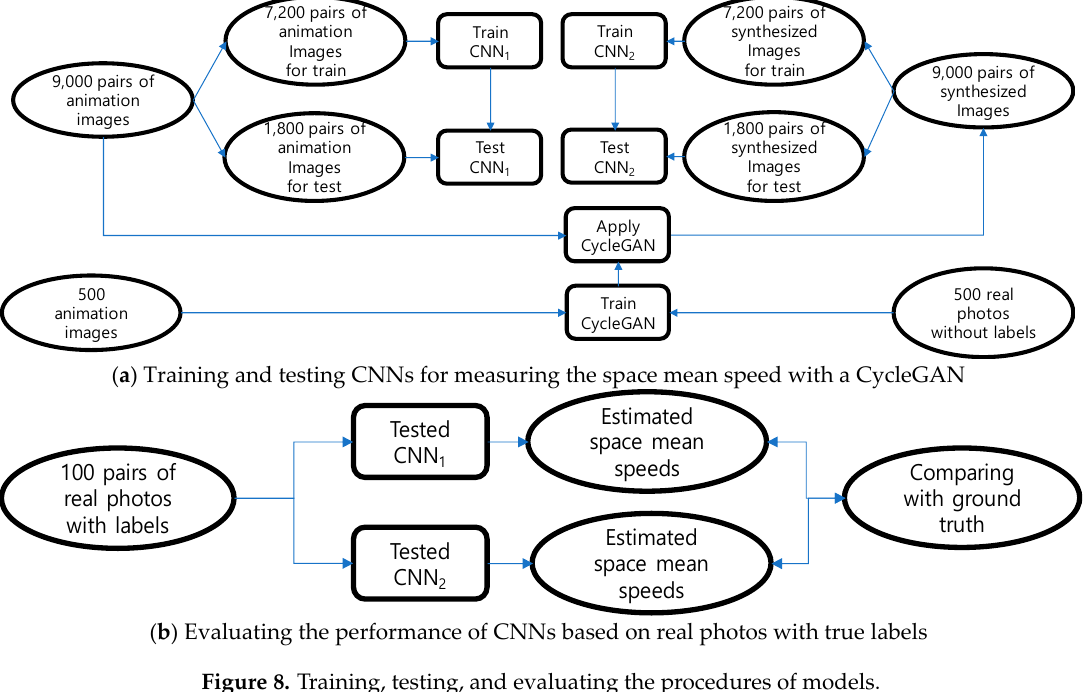
Figure 8. Training, testing, and evaluating the procedures of models.